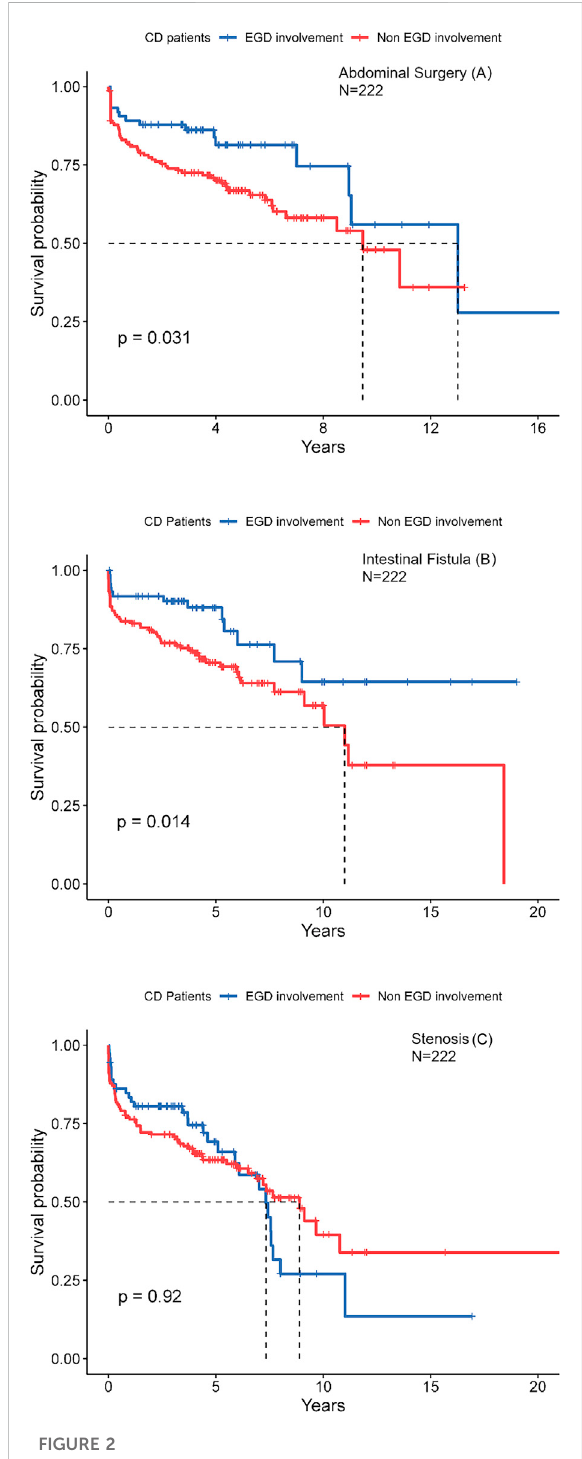
FIGURE 2 Kaplan-Meier analysis for the occurrence of abdominal surgery (A) , internal fi stula (B) , stenosis (C)